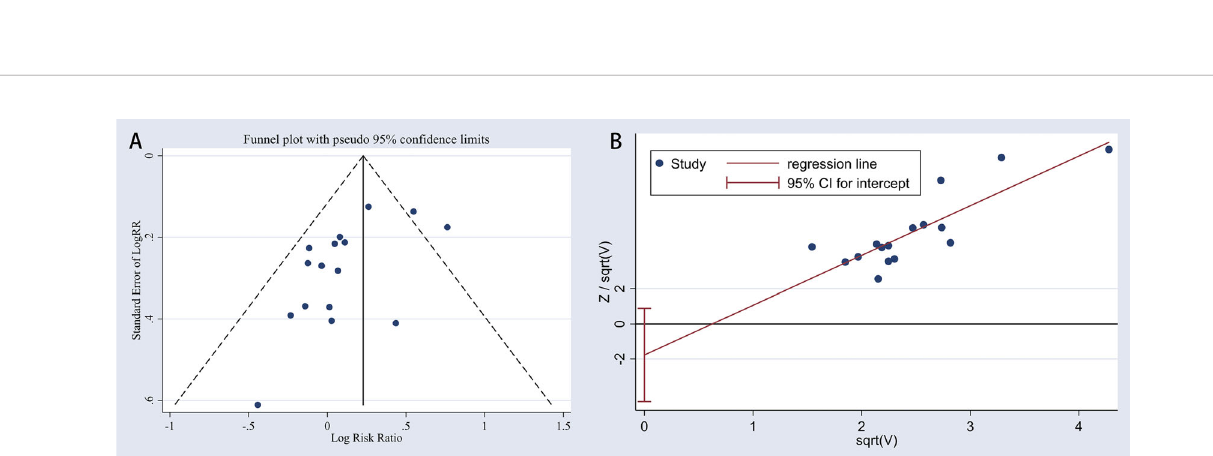
Frontiers in Oncology |